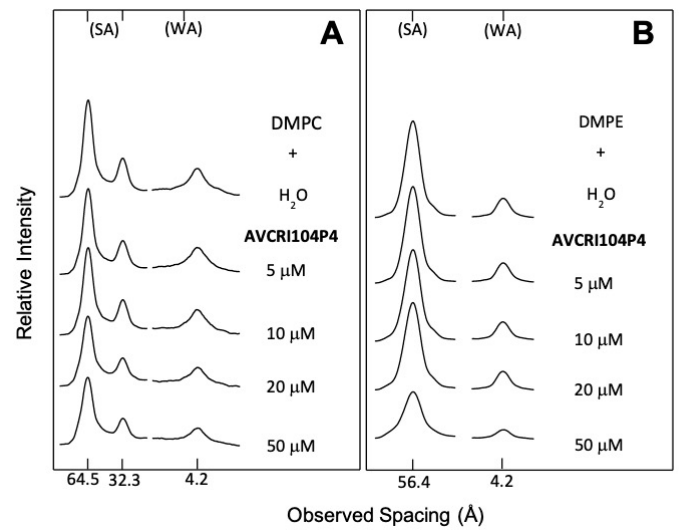
Figure 3. X-ray diffraction patterns of ( A ) dimyristoylphosphatidylcholine (DMPC) and ( B ) dimyristoylphosphatidylethanolamine (DMPE) in water and incubated with aqueous solutions of AVCRI104P4; (SA) small-angle and (WA) wide-angle reflections. Table 1. Decrease in the area under the curve (%) in the (SA) small-angle and (WA) wide-angle reflections of DMPC and DMPE by the effect of AVCRIP104P4. Percentages obtained from the analysis of microdensitograms from X-ray diffraction patterns of DMPC and DMPE in water and incubated with AVCRI104P4 solutions. AVCRI104P4 Area Under Curve Decrease